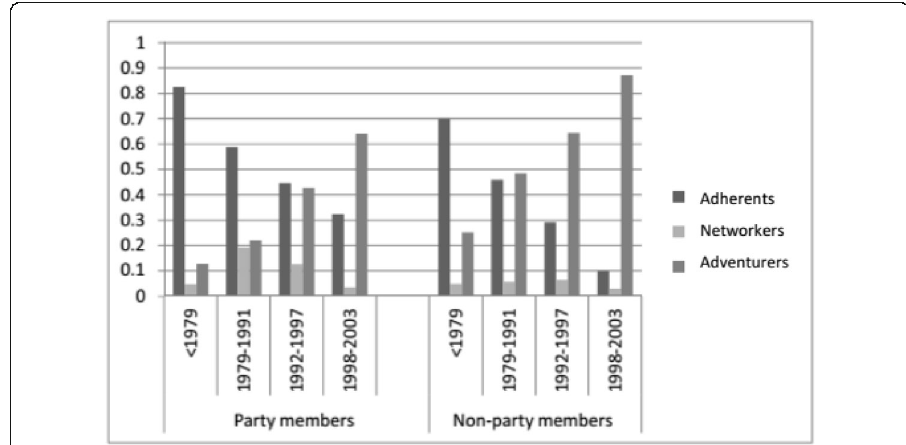
Fig. 4 Predicted probabilities of three types of successful job seekers by party membership and job entry era — the left section shows compositions for party members and the right section shows compositions for non-party members; four time periods are marked along the X-axis , while probabilities (between 0 and 1) are marked along the Y-axis ; the darkest grey colour indicates adherents, the lightest grey colour indicates networkers, and the last one indicates